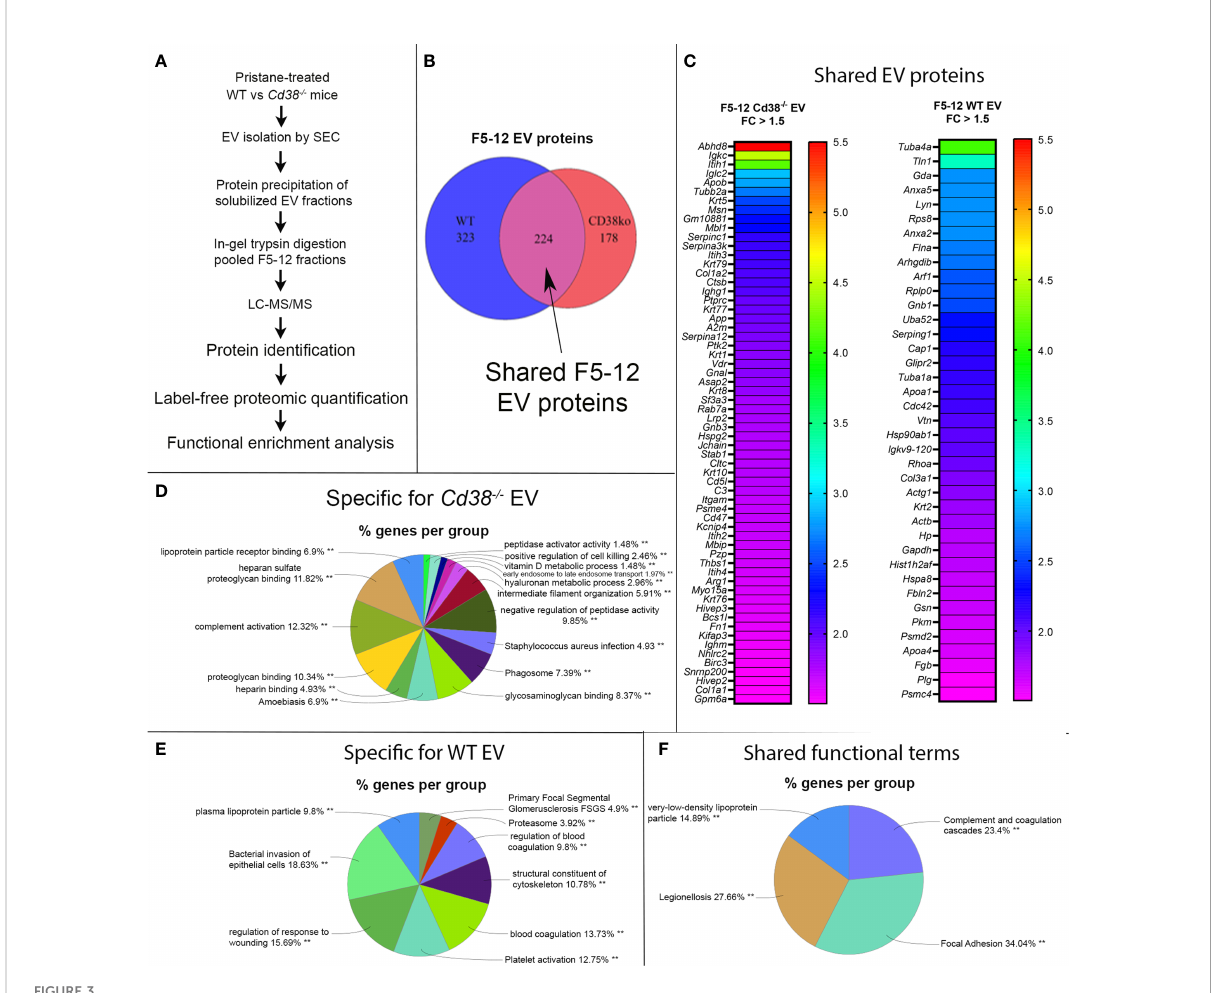
FIGURE 3 (A) General work fl ow for LC-MS-based EV protein identi fi cation, protein quanti fi cation and functional enrichment of samples from pristane- treated WT vs Cd38 -/- mice. (B) Venn diagram of proteins identi fi ed in peritoneal F5-12 Cd38 -/- EV versus F5-12 WT EV from pristane-treated mice. In red, 178 proteins unique for Cd38 -/- EV. In blue, 323 proteins unique for WT EV. In purple, shared proteins identi fi ed in both EV types. (C) Heat-maps showing increased protein abundance in F5-12 Cd38 -/- EV relative to F5-12 WT EV (left), and increased protein abundance in